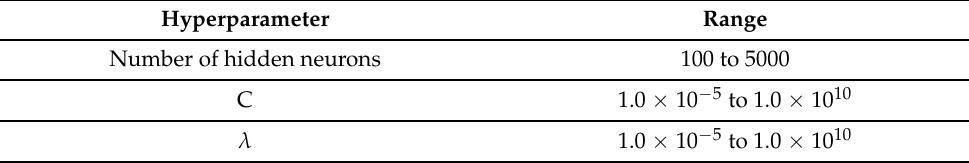
Table 3. Hyperparameter selection range for